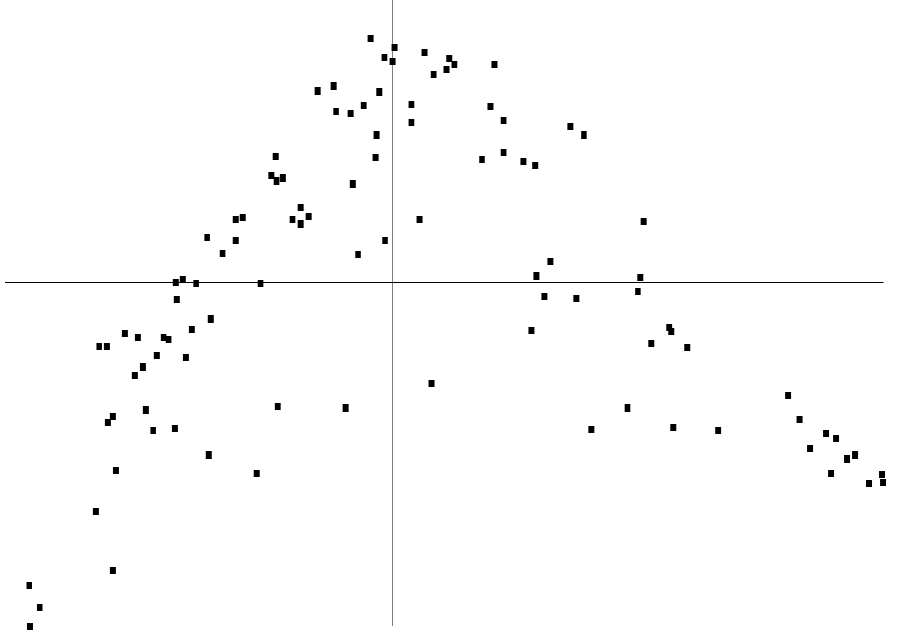
Figure 5. Results of the Eigenmap method, before determining the clusters. Nearby patients should be similar in some